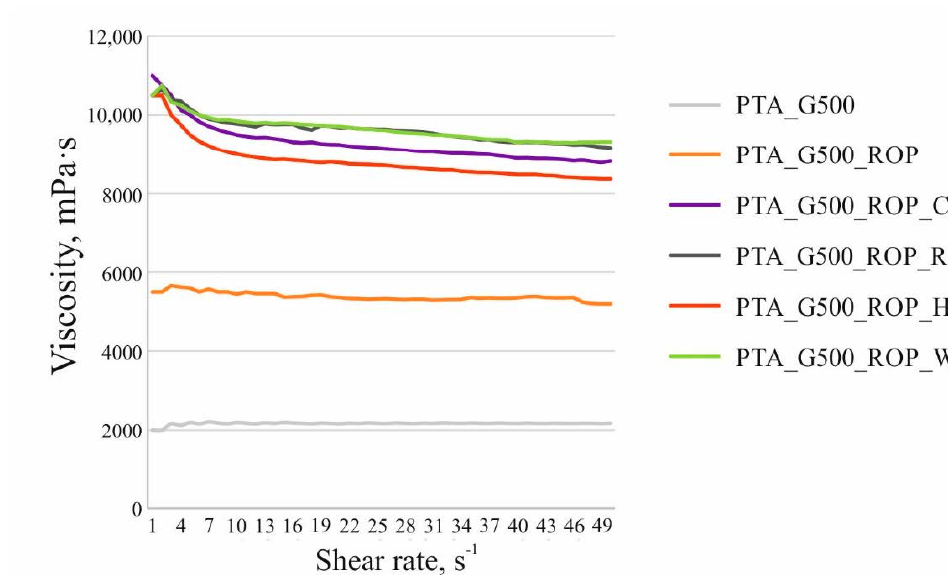
Figure 4. Viscosity curves for mixtures of polyols and mixtures of polyols with natural fillers. PTA_G500—the mixture of polyols Polios ® 420 PTA and Rokopol ® G500 in a 3:1 weight ratio; PTA_G500_ROP—the mixture of polyols Polios ® 420 PTA, Rokopol ® G500, and ROP in a 18.75:6.25:75 weight ratio (see Table 1); PTA_G500_ROP_CH/R/HS/WS—the mixture of polyols Polios ® 420 PTA, Rokopol ® G500, ROP, and natural fillers in a 18.75:6.25:75:15 weight ratio (see Table